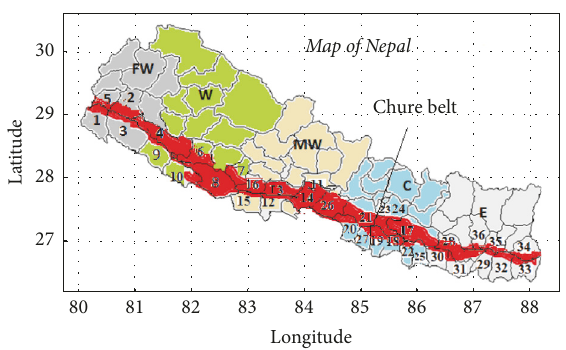
Figure 1: Map of Nepal showing Chure region (red belt) with 36 districts within 5 development regions. FW = far western, W = western, MW = mid-western, C = central, and E =